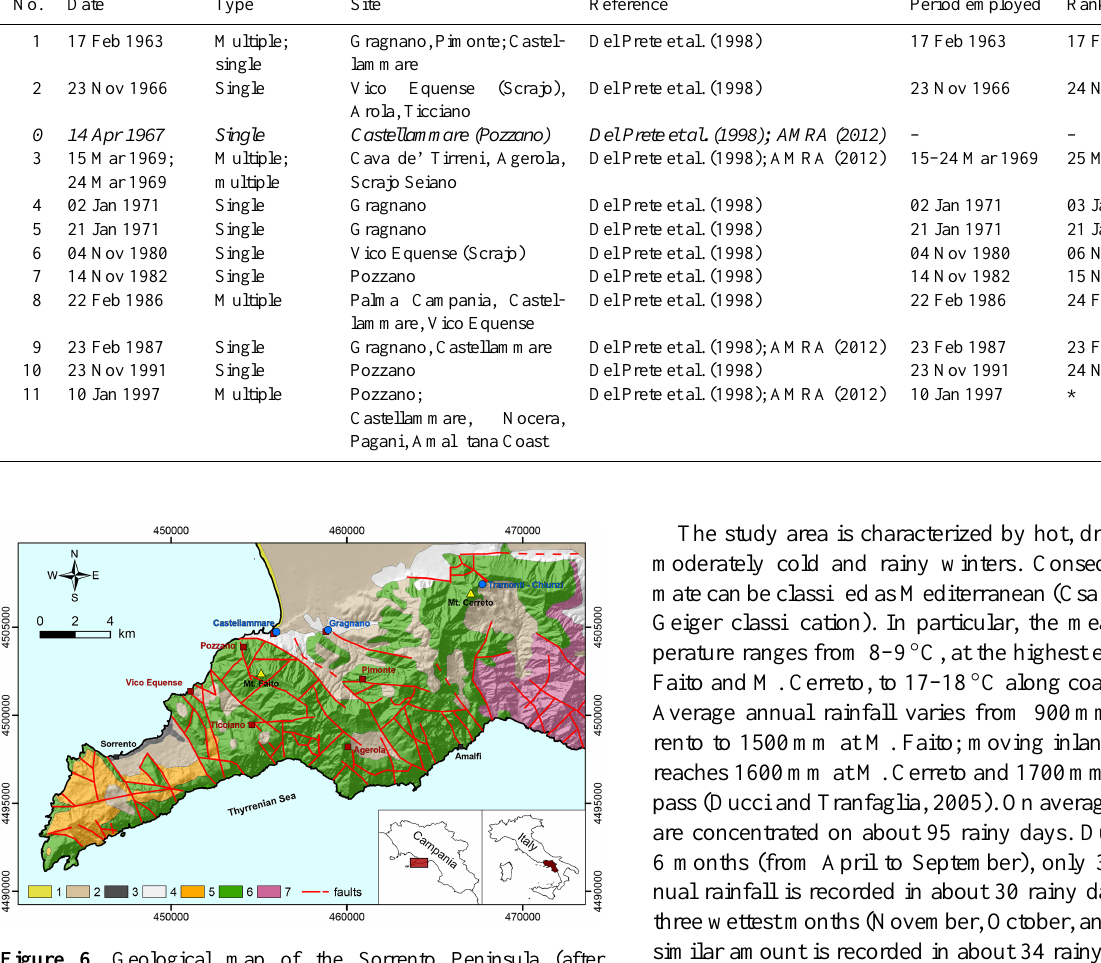
Figure 6. Geological map of the Sorrento Peninsula (after Di Crescenzo and Santo, 1999, mod.). Key: (1) beach de- posit (Holocene); (2) pyroclastic fall deposit (late Pleistocene– Holocene); (3) Campanian ignimbrite (late Pleistocene); (4) de- trital alluvial deposit (Pleistocene); (5) flysch deposit (Miocene); (6) limestone (Mesozoic); (7) dolomitic limestone (Mesozoic). Red squares mark sites affected by shallow landslide activations; blue circles, the rain gauges; black squares, the main localities; yellow triangles, the highest mountain